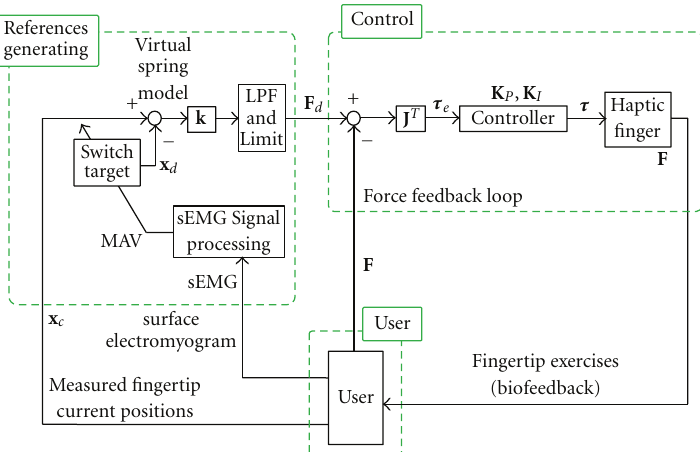
Figure 5: The control block diagram. This system can be divided into three parts: user, robot system including controller, and desired force generator from sEMG and fingertip positions. The details of the robot control method are given in Section 2.5.